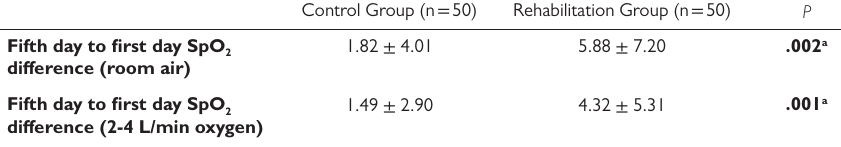
Difference Between Groups 2